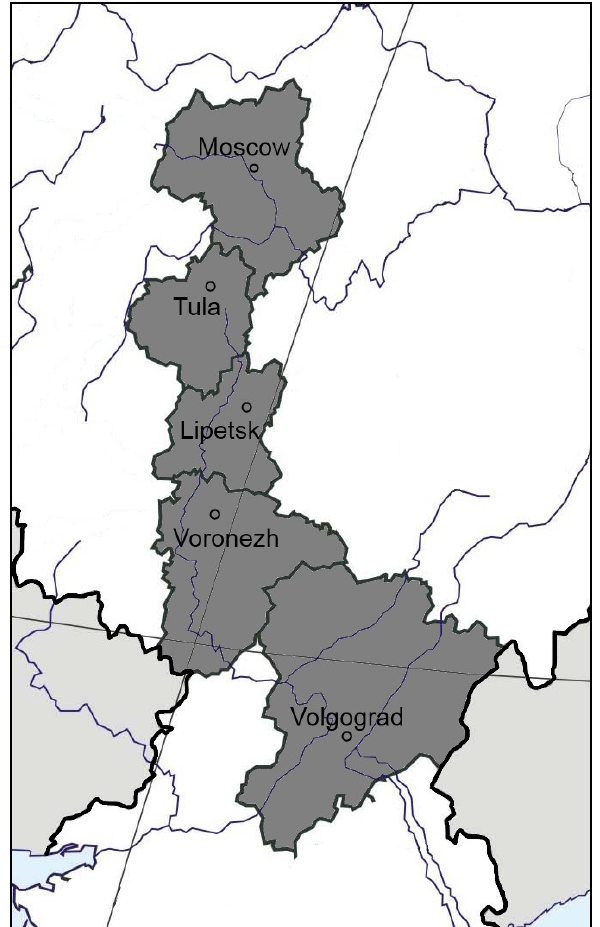
Figure 1. Map of the European part of Russia, where the soils samples were